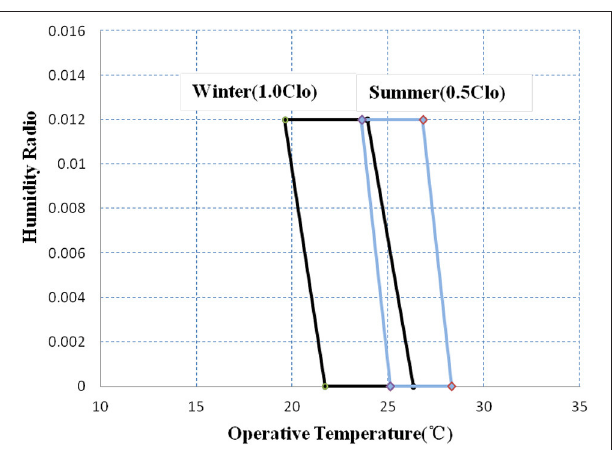
FIGURE 2 | Indoor thermal comfort zone based on temperature and humidity ratio (GB 2012).